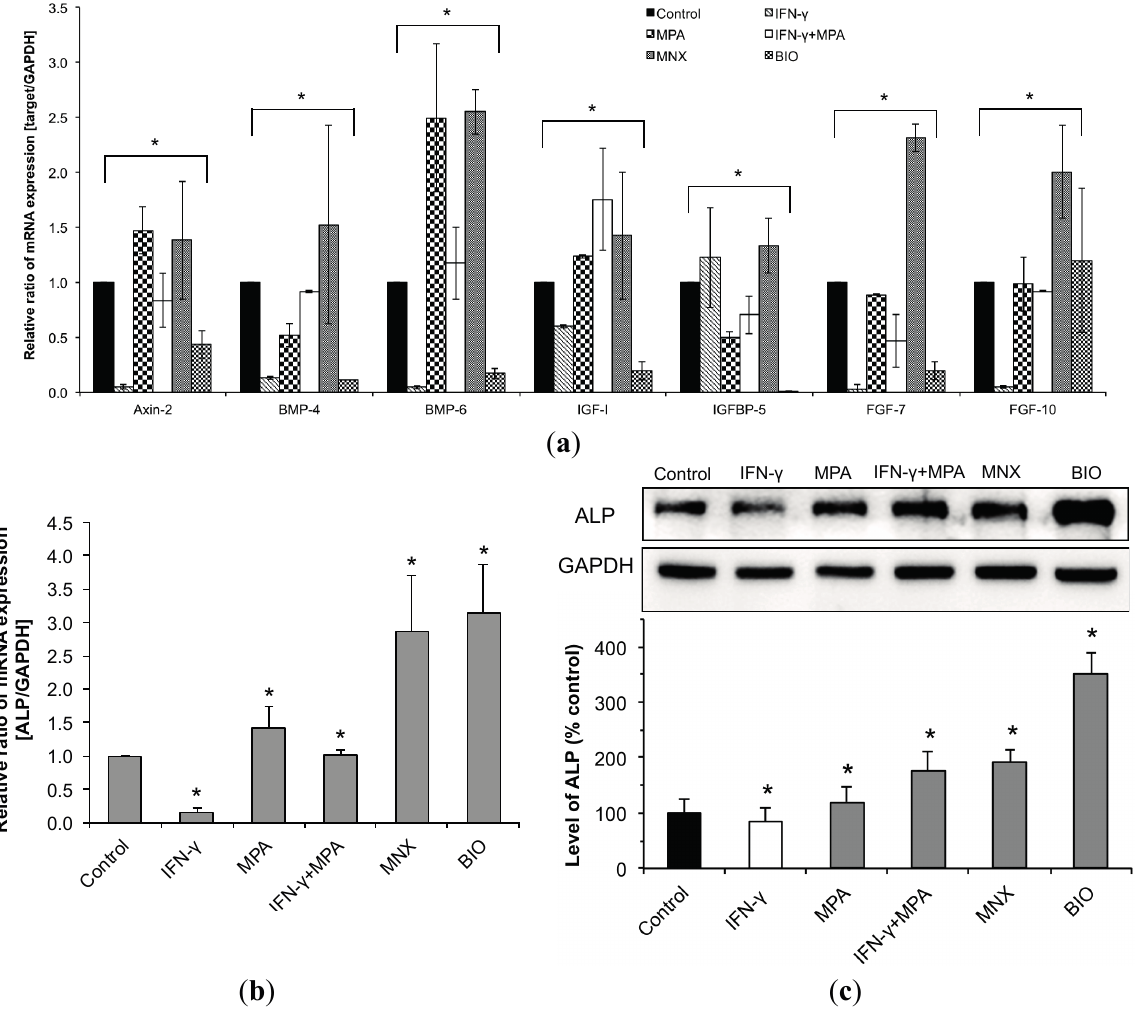
2.5. MPA Inhibits the Up-Regulation of Transforming Growth Factor (TGF)- β 2 Induced by IFN- γ in